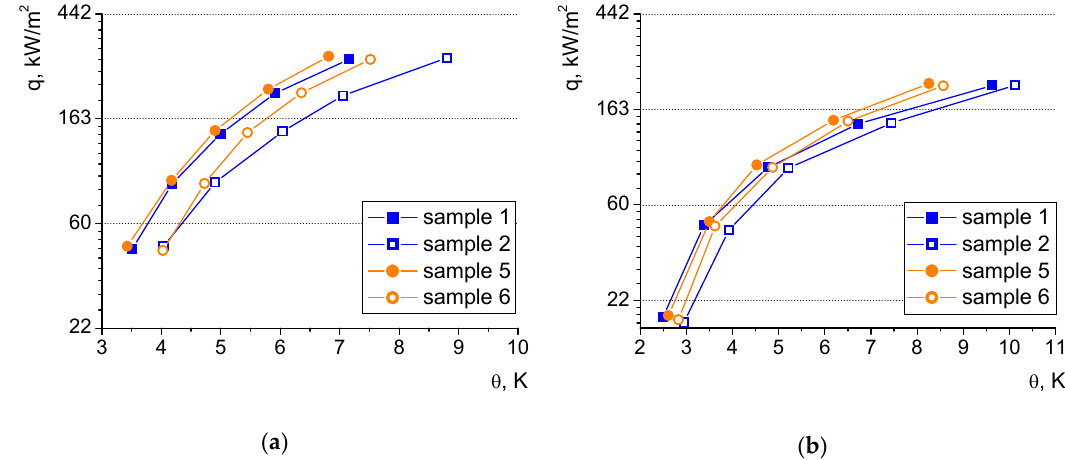
Figure 7. Heat flux vs. wall superheat for samples of different fin width and height; ( a ) distilled water, ( b ) ethyl alcohol.